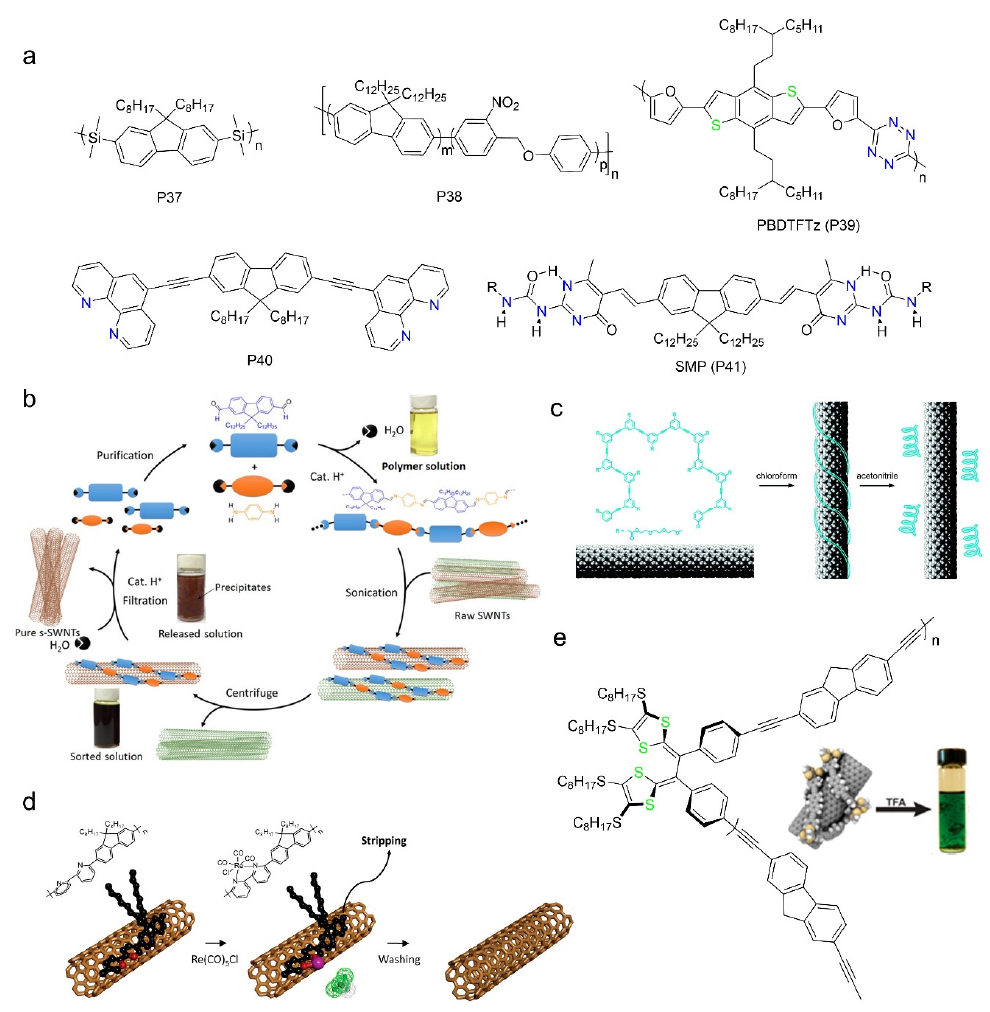
Figure 8. Removable/recyclable polymers used for sorting. ( a ) Chemical structures of removable/recyclable polymers containing degradable groups; ( b ) schematic diagram of PF-PD sorting and recycling process. The polymer can be decomposed by adding catalyst amount of TFA and the monomers are reused for next sorting process. Reprinted with permission from Lei, T. et al., 2016. Copyright 2016 American Chemical Society; ( c ) conformational change of foldable polymer by changing solvent. Reprinted with permission from Zhang, Z. et al., 2010. Copyright 2010 American Chemical Society; ( d ) the removal of PFO-BPy (P5) by complexation reaction with metal ions. Reprinted with permission from Joo, Y. et al., 2015. Copyright 2015 American Chemical Society; ( e ) Chemical structure of tetrathiafulvalene vinylogue (TTFV)-fluorene copolymer. Picture next to it indicates the release of the polymer from SWNTs after adding TFA. Reprinted with permission from Liang, S. et